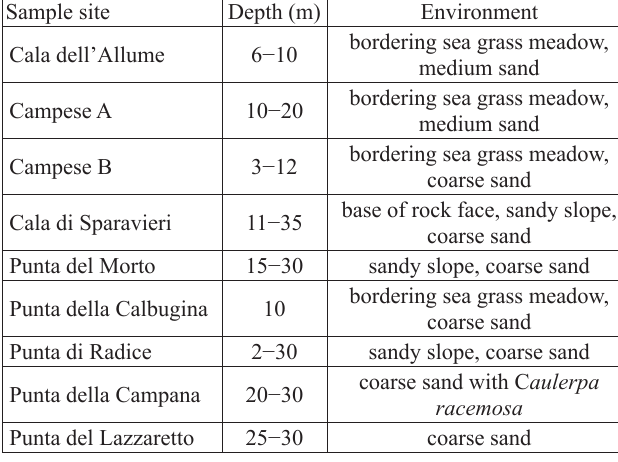
Table 1. Sites around Giglio according to sample depth and environ-